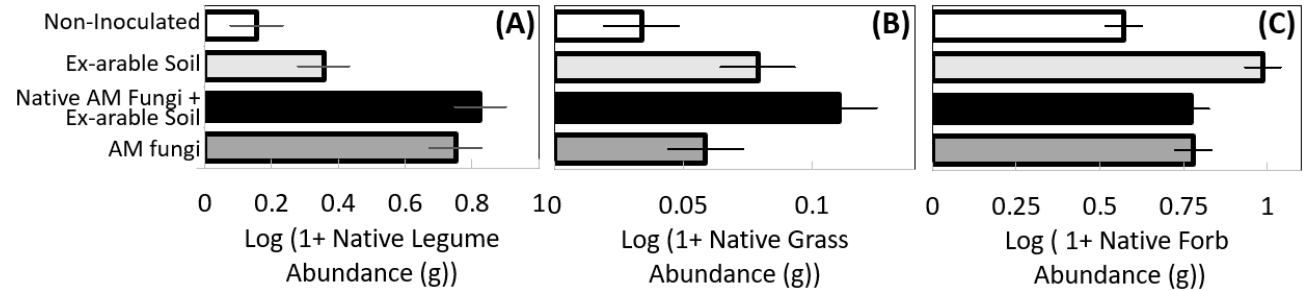
Figure 5. The effect of inoculation treatment (native AM fungi (dark grey), native AM fungi + ex-arable soil (black), ex-arable soil (light grey), and the non-inoculated control (white)) on native ( A ) legume, ( B ) grass, and ( C ) forb abundance. Bars represent the LS means of plant aboveground biomass and error bars are standard error from the Proc GLM models.